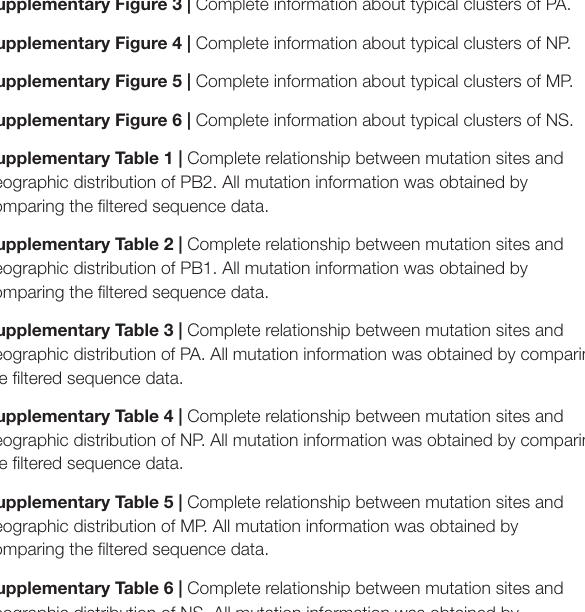
Supplementary Figure 3 | Complete information about typical clusters of PA. Supplementary Figure 4 | Complete information about typical clusters of NP. Supplementary Figure 5 | Complete information about typical clusters of MP. Supplementary Figure 6 | Complete information about typical clusters of